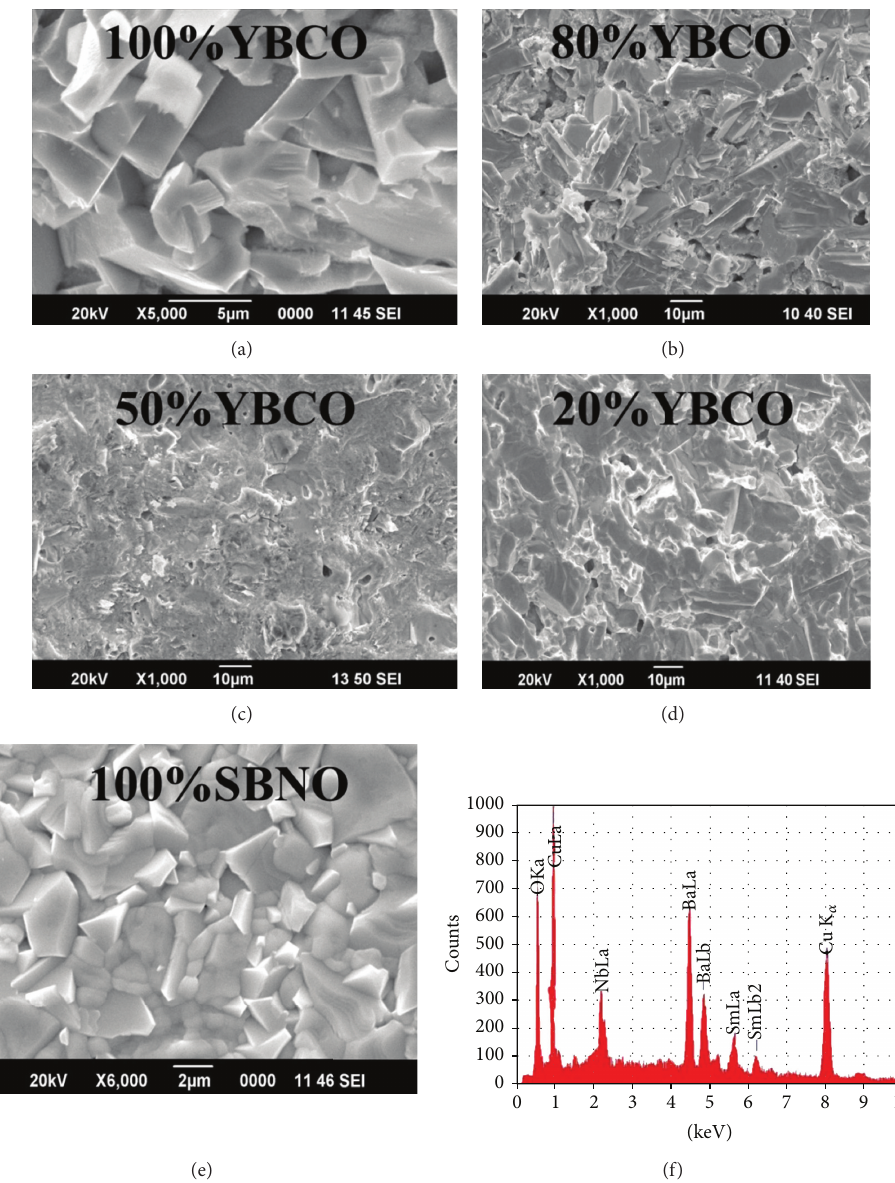
Figure 4: SEM images of different compositions of YBCO-SBNO composite and EDAX spectrum of a 1:1 mixture of YBCO and SBNO.